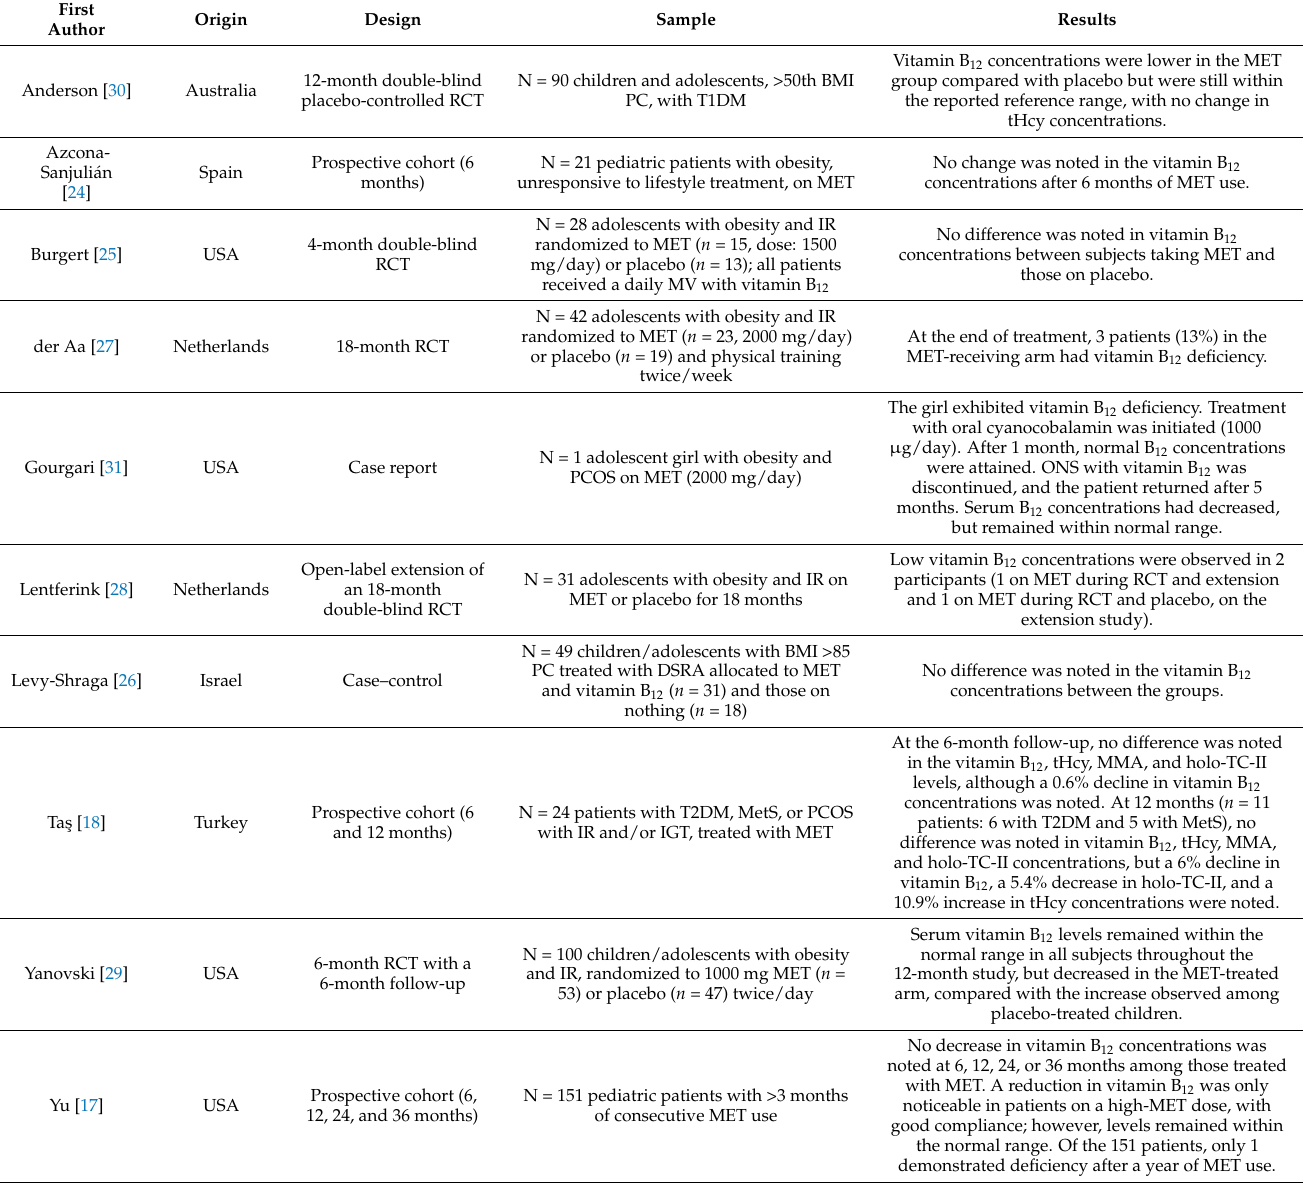
Table 3. Studies assessing vitamin B 12 status in children and adolescents on MET